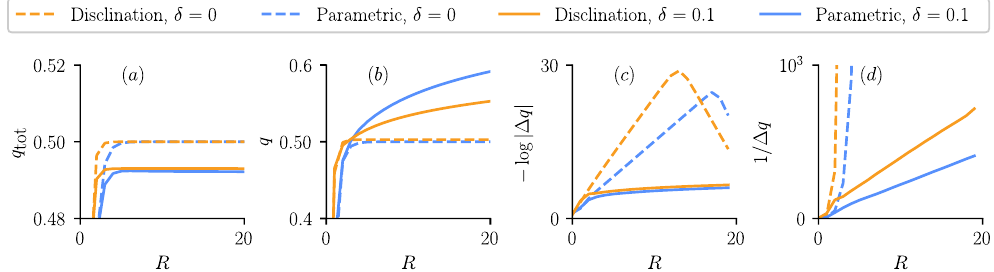
Figure 4: The defect charge diverges in the absence of sublattice symmetry. (a) The total charge q integrates to 1 / 2 only when sublattice symmetry is present (dashed tot lines), otherwise q depends on the integration area (solid lines), demonstrating tot the lack of absolute convergence. (b) In the presence of sublattice symmetry (dashed lines), the charge deviation q is quantized to 1 / 2, otherwise it diverges (solid lines). The divergence of the parametric defect’s charge is more pronounced when the paths are asymmetric in parameter space. (c) The defect charge deviation converges expo- nentially when δ = 0 (dashed lines), as − log | q ( R + 1 ) − q ( R ) | ∝ R . (d) For δ ̸ = 0 the local charge density decays as 1 / R 2 as indicated by q ( R + 1 ) − q ( R ) ∝ 1 / R